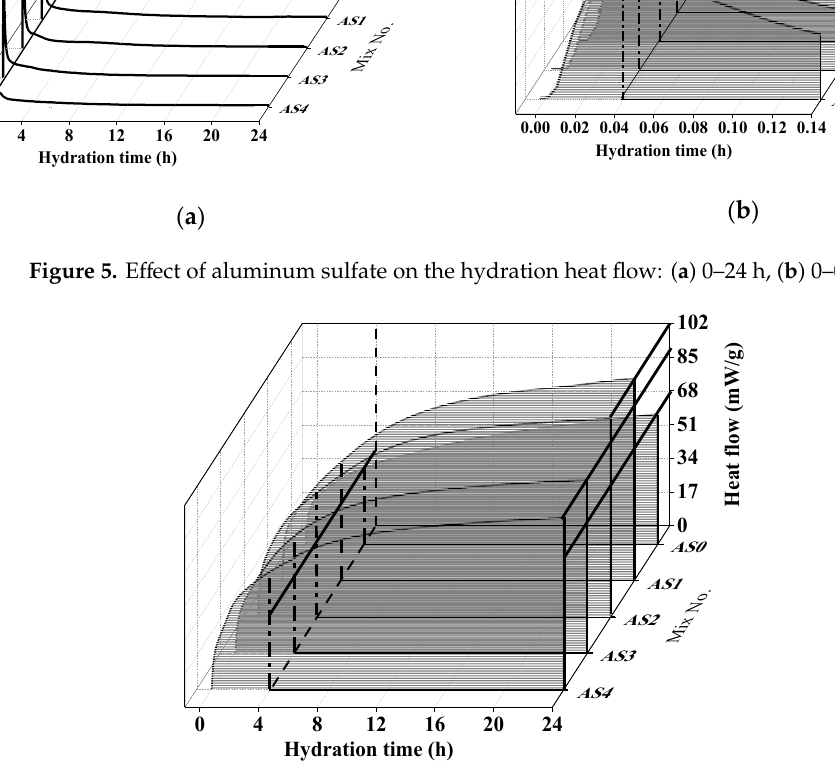
Figure 5. Effect of aluminum sulfate on the hydration heat flow: ( a ) 0–24 h, ( b ) 0–0.14 h.